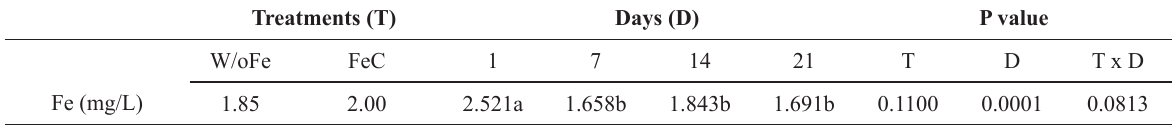
Iron concentration (mg/L) in the milk of sows fed diets with or without iron chelate supplementation at day 1 (colostrum), 7, 14 and 21 days of lactation.